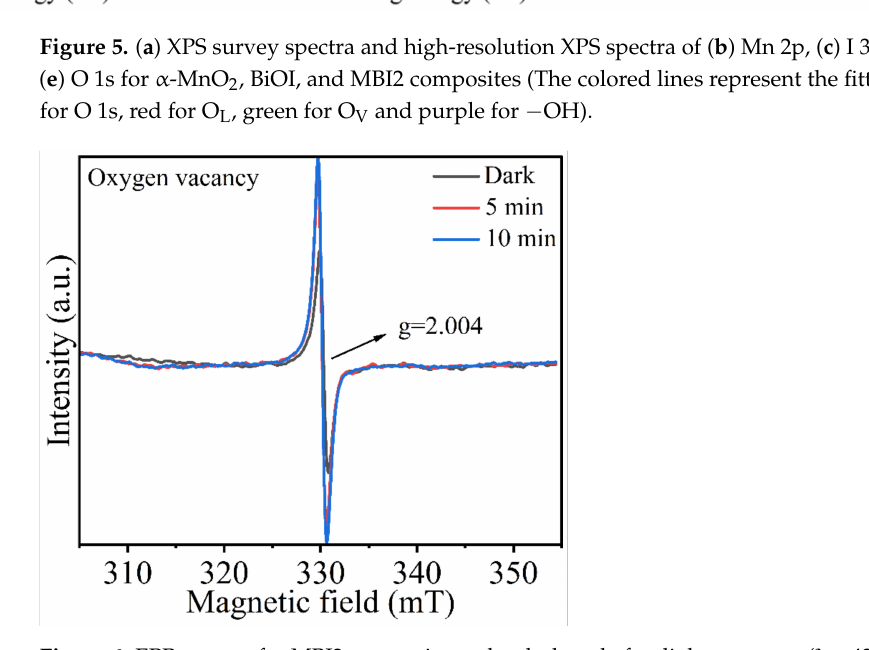
Figure 6. EPR spectra for MBI2 composite under dark and after light exposure ( λ > 420 nm) for 5 and 10